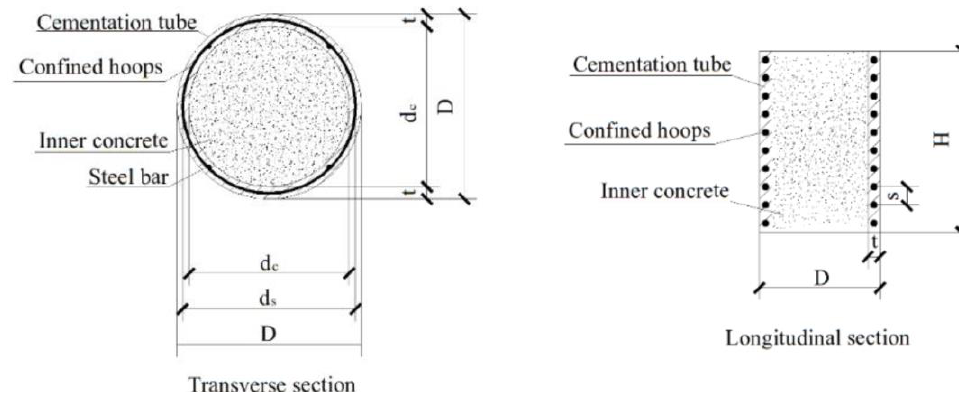
Figure 1. Transverse and longitudinal section of specimens. Table 1. Tested specimens’